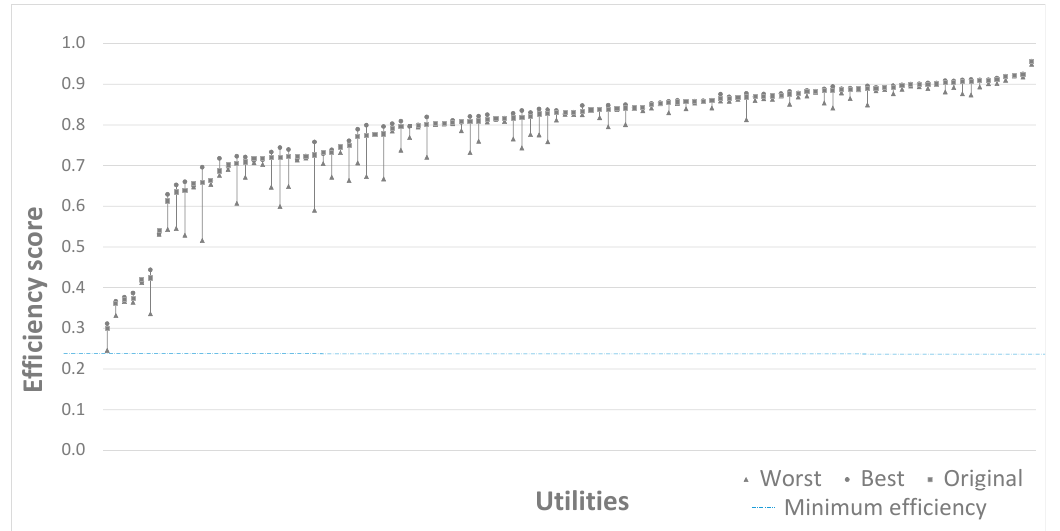
Figure 3. Minimum, maximum, and original stochastic frontier analysis (SFA) results for the reduced